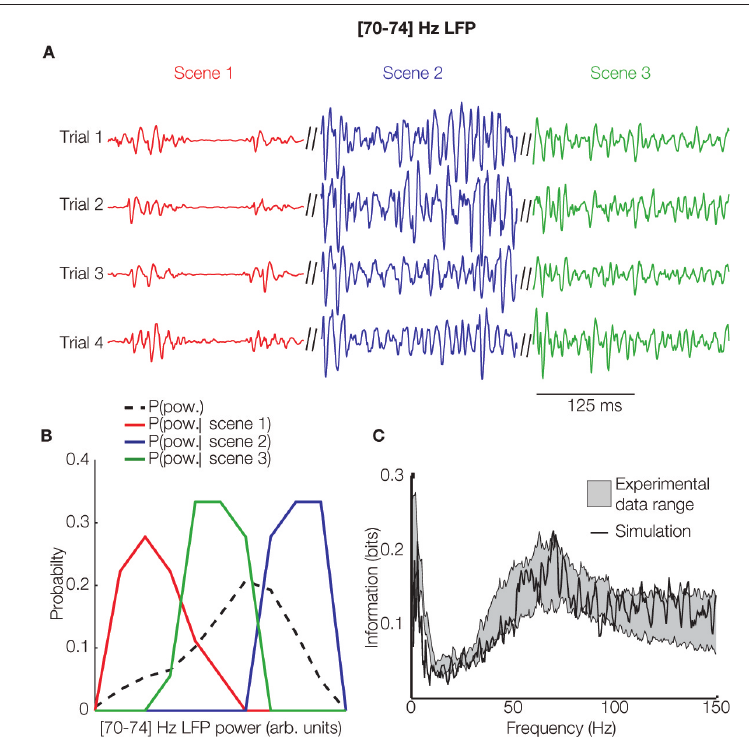
Figure 2 | Computing the information content of LFP spectrum in models and cortical data. (A) The time course of the 70–74 Hz component of simulated LFP’s generated from the recurrent inhibitory–excitatory neural network model of Mazzoni et al. (2008) for four repetitions of the same thalamic input signal during three 2-s nonoverlapping movie intervals (“scenes”), each coded with a different color. The power of the 70–74 Hz band varies reliably from scene to scene. (B) The distribution across 30 trials of the time-averaged instantaneous power within each scene (red, green, and blue lines coded as in (A) ) is different across different scenes and from the distribution of power across all available scenes (black dashed line). This shows that the power in this frequency band carries some single-trial information about movie scenes. (C) The mutual information (about which scene of the movie was being presented) carried by the power of the LFP recorded from primary visual cortex (grey area represents the mean ± SEM over recoding locations) and by the power of the LFP simulated by the recurrent network model of Mazzoni et al. (2008) (black line), from which this panel is reprinted. The model accurately reproduced the spectral information of recorded